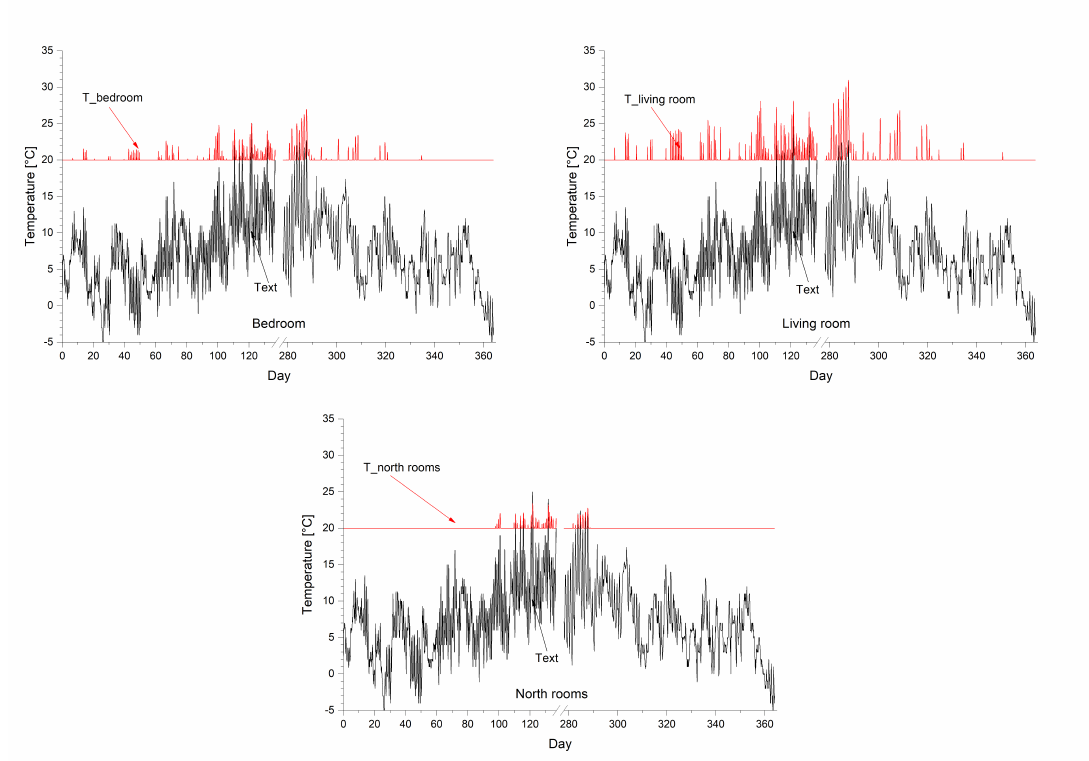
Figure 6. Temperature variations inside the bedroom, the living room, and the north-facing rooms for the simulation of the reference case versus T ext . T ext denotes the variation in outdoor air